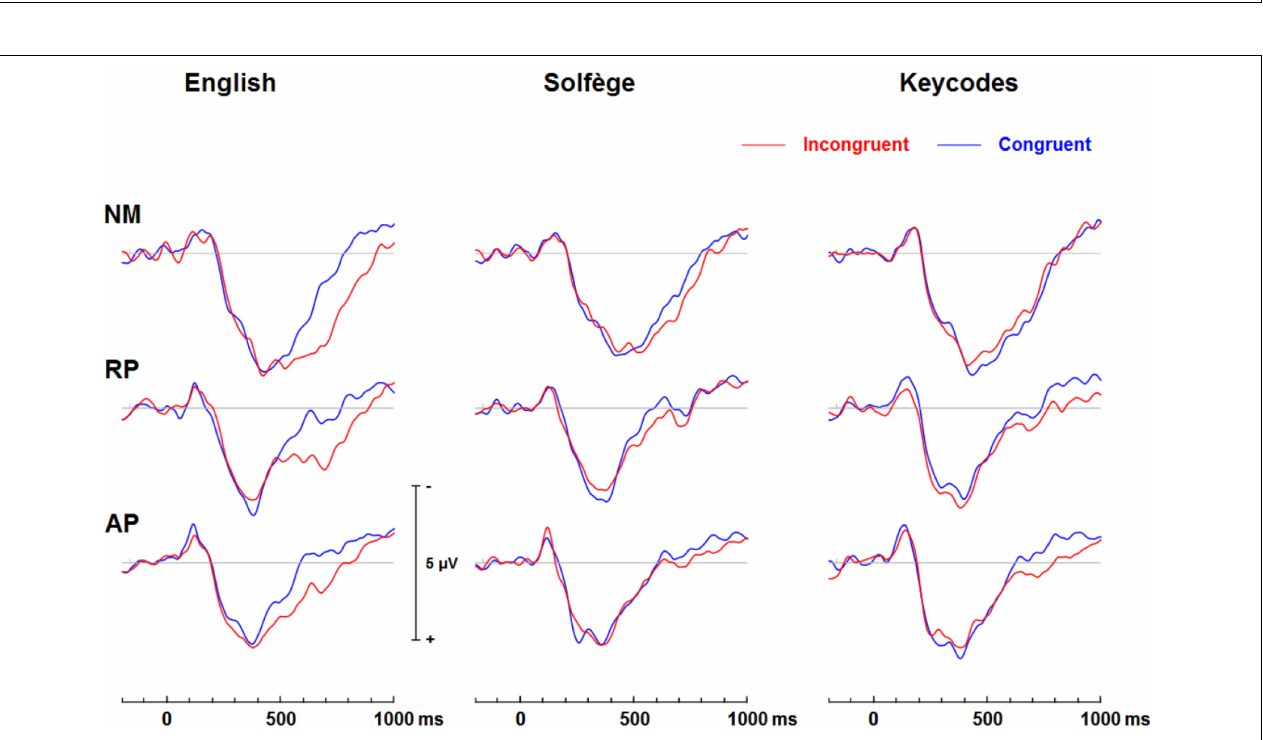
FIGURE 3 | Event-related potential waveforms of congruent and incongruent conditions for each task at the FCz site. A clear N1 and P2 neural electric modulation is visible, along with an expected N450. English words show a congruency effect for all groups for the N450 but only AP shows this effect for keycodes.